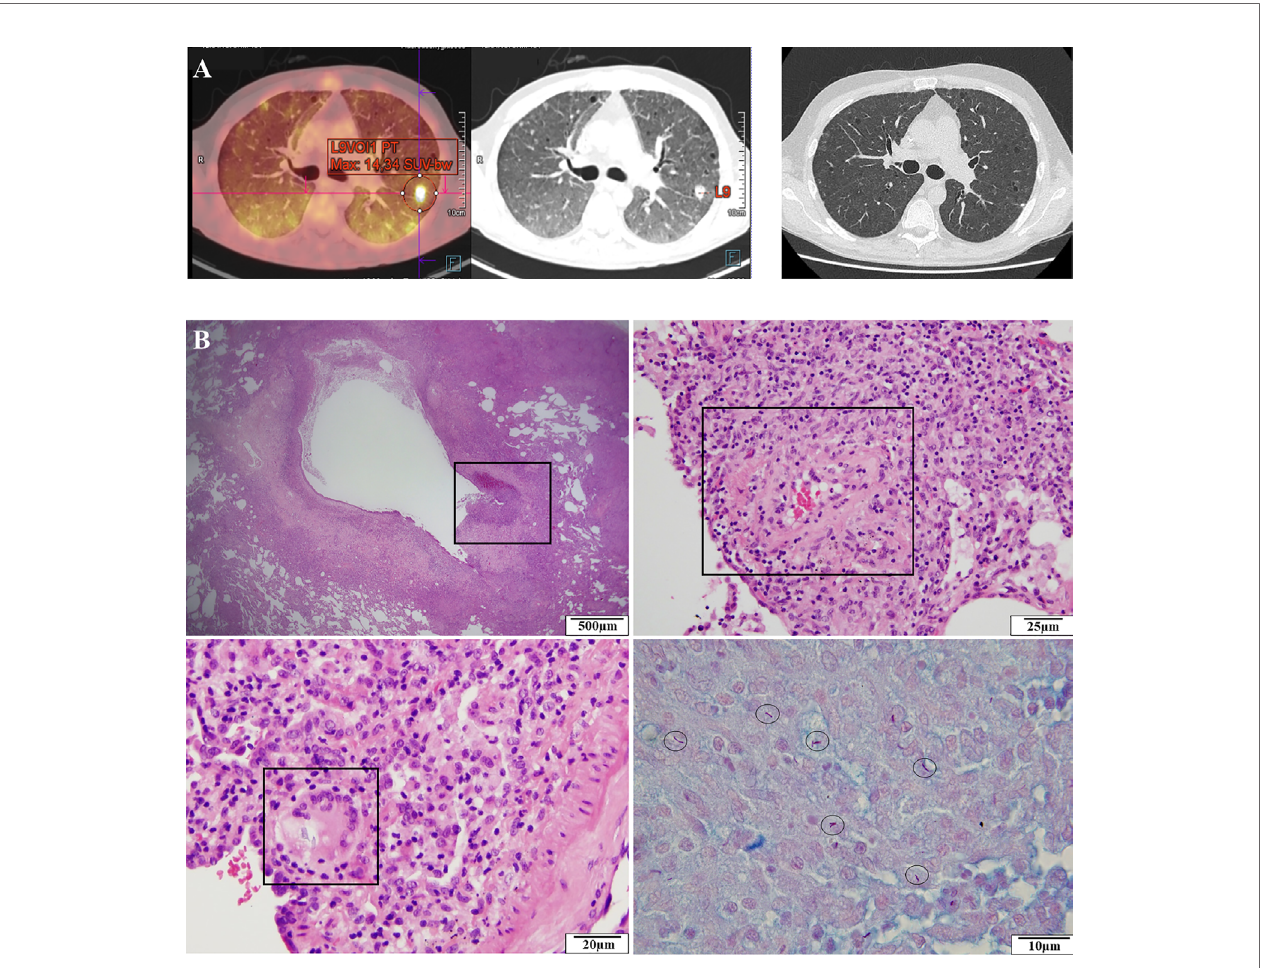
FIGURE 2 | Clinical evolution and histological analysis of the patient. (A) 18F-FDG-TEP-CT-scan revealing an interstitial lung disease with nodular lesions (left). CT- scan normalization after 3 months (right). (B) Histological analysis showing a peri-bronchial granulomatous in fl ammation with ulceration (upper left), a perivascular granuloma (upper right), giant multinucleated cells (lower left), and BAAR with Ziehl-Neelsen staining (lower